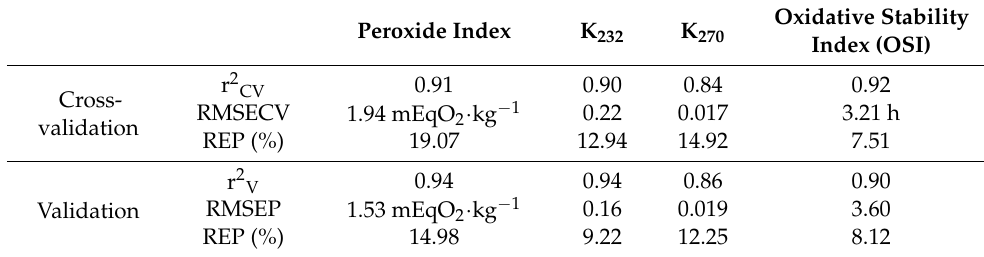
Oxidative Stability Index (OSI)